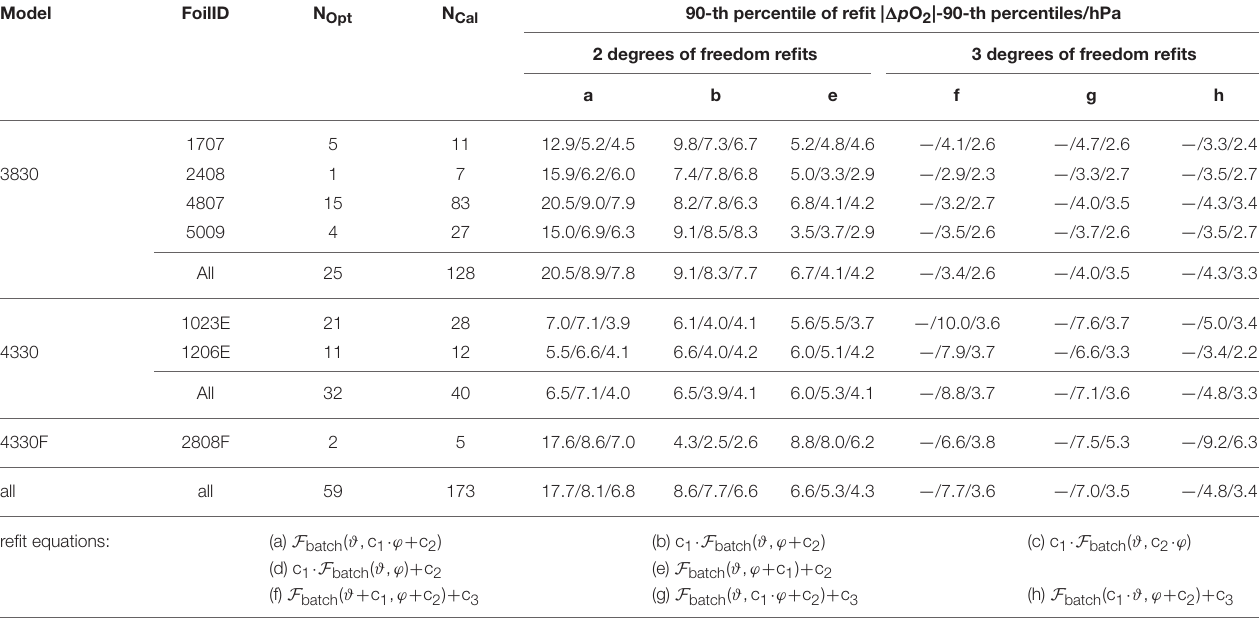
TABLE 1 | Accuracy of batch foil O 2 - ϑ -response adjustment to individual multi-point optode calibrations using refit approaches with two (a–e) and three degrees of freedom (f–h). Model